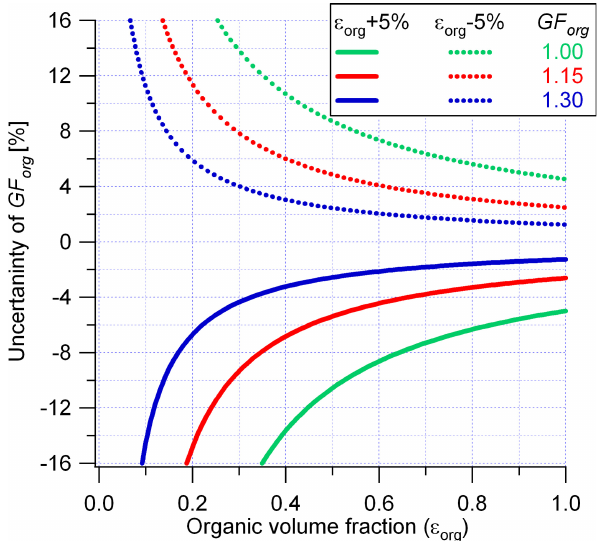
Fig. 2. Uncertainty of the retrieved GF org due to AMS uncertainties. Errors calculated with ε org ± 5% ( ε org − 5% for dashed line and ε org + 5% for the filled lines) and an inorganic GF=1.56, assuming 3 different GF org : 1, 1.15 and 1.3. With a higher GF org or with a higher ε org , the uncertainty of the calculated GF org decreases. For example, for a non hygroscopic organic (GF org = 1), the retrieved GF org is 1 ± 0 . 06 at ε org = 0 . 8 and 1 ± 0 . 14 at ε org = 0 . 4, whereas for a hygroscopic organic (GF org = 1 . 3) the retrieved GF org is 1 . 3 ± 0 . 02 at ε org = 0 . 8 and 1 . 3 ± 0 . 04 at ε org = 0 . 4.